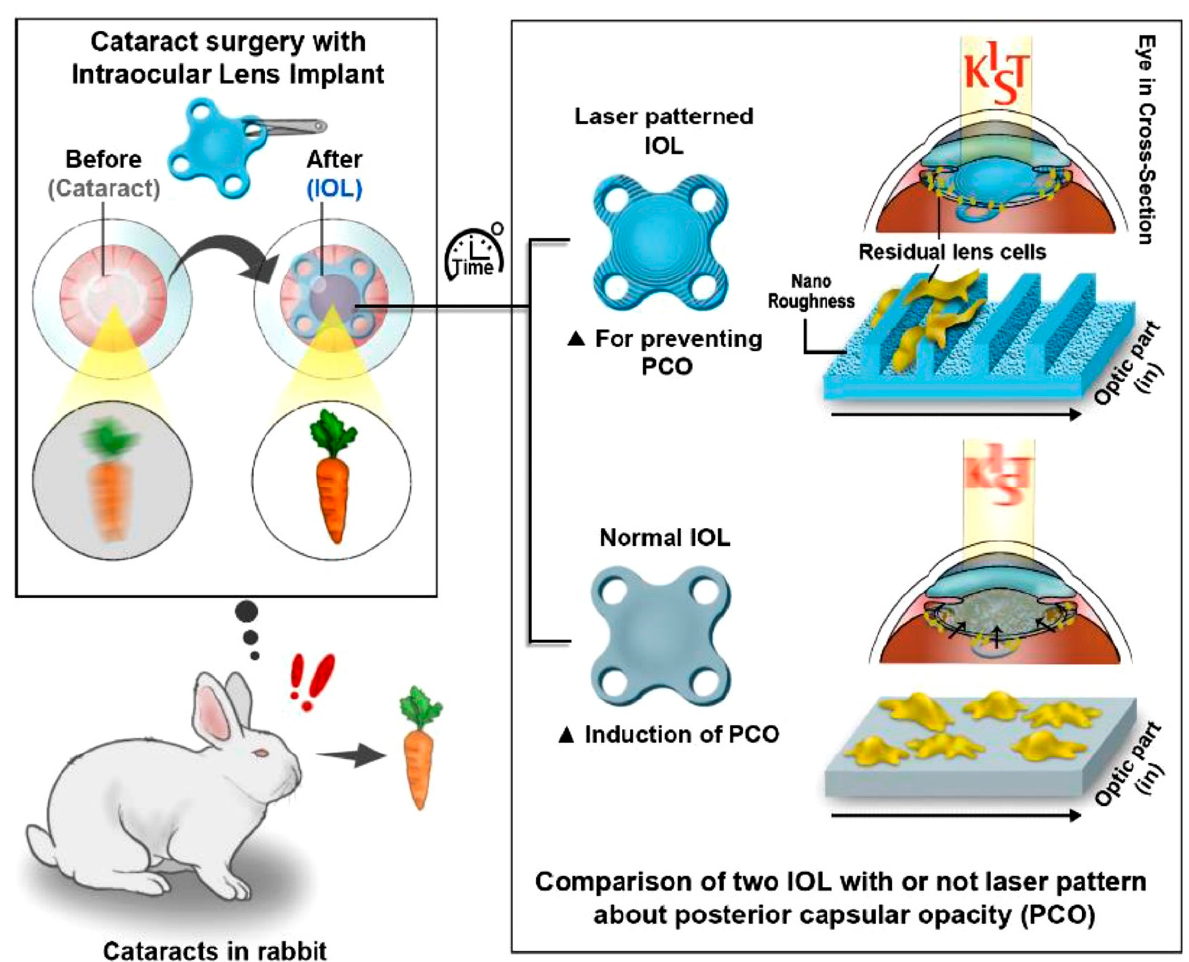
Figure 4. Schematic illustration of nano-textured micro-patterning on intraocular lens to suppress posterior capsular opacification by regulating cell behavior, such as adhesion, migration, and proliferation. Adapted with permission from Ref. [73]. Copyright 2020 Elsevier.